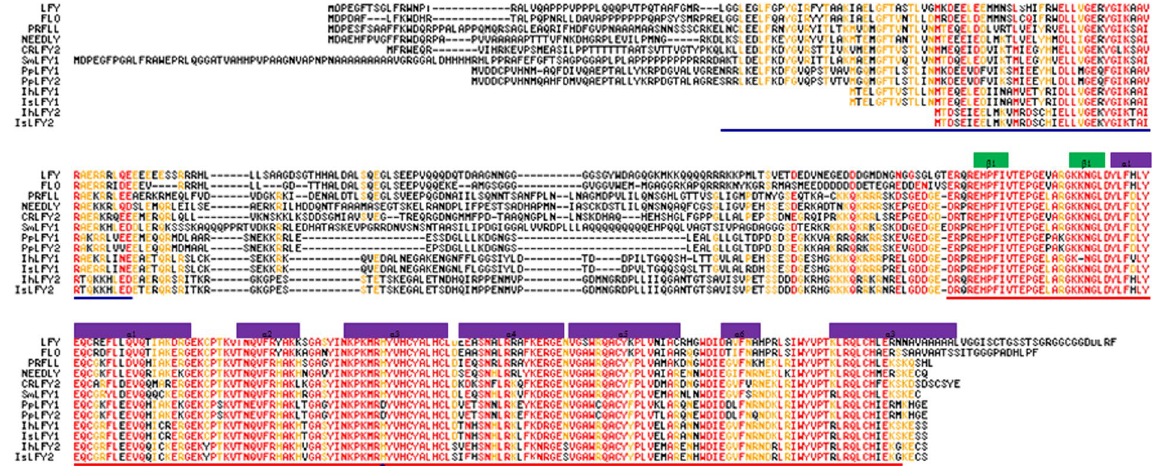
Figure 2. Sequences comparison of deduced LFY proteins. Deduced amino acid sequences of IhLFY1 and IhLFY2 for I. hypsophila , as well as IsLFY1 and IsLFY2 for I. sinensis were compared with LFY homologs, including LFY ( Arabidopsis thaliana , AAA32826), FLO ( Antirrhinum majus , AAA62574.1), PRFLL ( Pinus radiata , O04116), NEEDLY ( Pinus radiata , AAB68601.1), CRLFY2 ( Ceratopteris richardii , BAB41070.2), SmLFY1 ( Selaginella moellendorffii , XP_002978027), PpLFY1 ( Physcomitrella patens , BAB60676.1), and PpLFY2 ( Physcomitrella patens , BAB60677.1). Conservatively substituted and identical residues were depicted on a red background, and slightly conserved residues were on an orange background. N-terminal and C-terminal domains were overlined in blue and red, respectively. Second structures of the C-terminal domains including two β -sheet and seven α -helix, were indicated. Gaps were shown as dashes to maximize the alignments. The blue triangle represented a conspicuously different amino acid between P. patens and the other